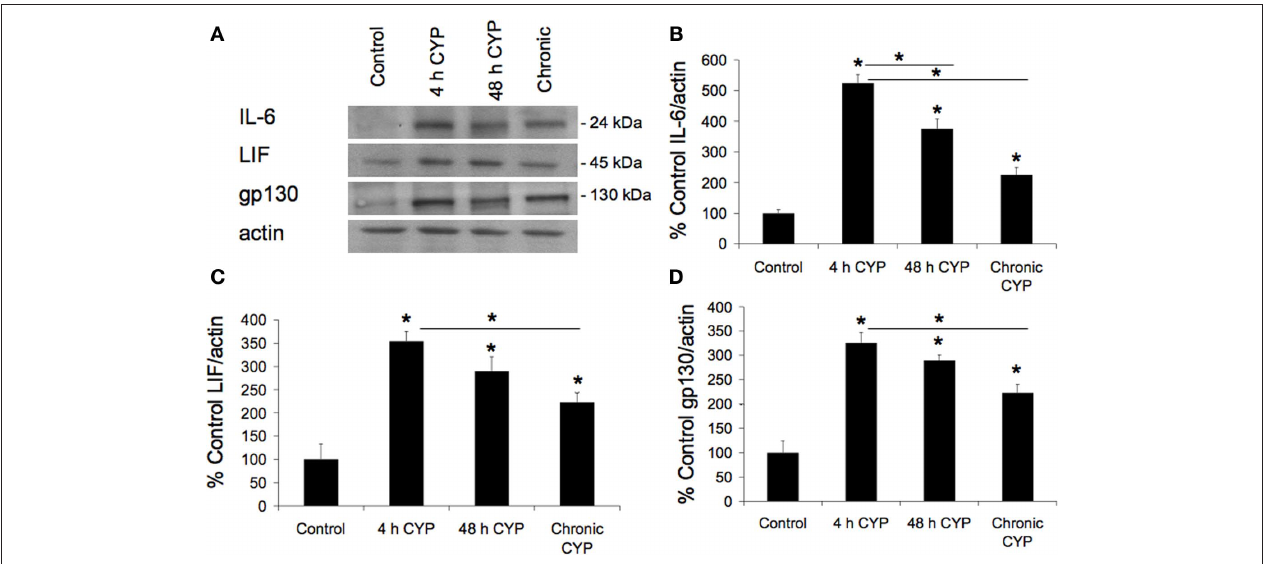
IL-6 (B) , LIF (C) , gp130 (D) band density in each group normalized to total actin expressed as a percentage of control (no inflammation). CYP-induced cystitis significantly ( p ≤ 0.01) increased IL-6, LIF, and gp130 expression in comparison to control urinary bladder. * p ≤ 0.01 versus control or as indicated between groups by horizontal lines. n = 6 for each